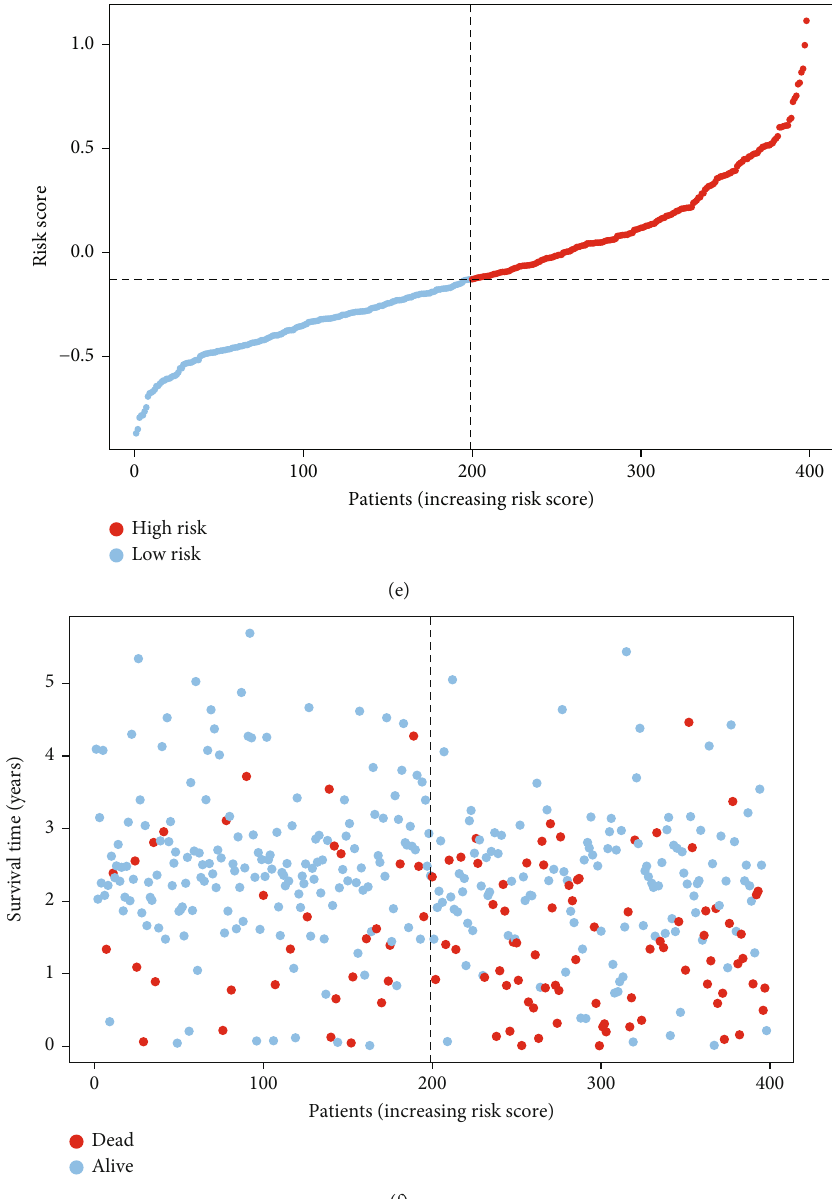
Figure 5: Relationship between risk score and survival status of patients. (a, c, e) Risk distribution curves. (b, d, f) Survival state curves. (a, b) TCGA-LUAD. (c, d) GSE31210. (e, f)